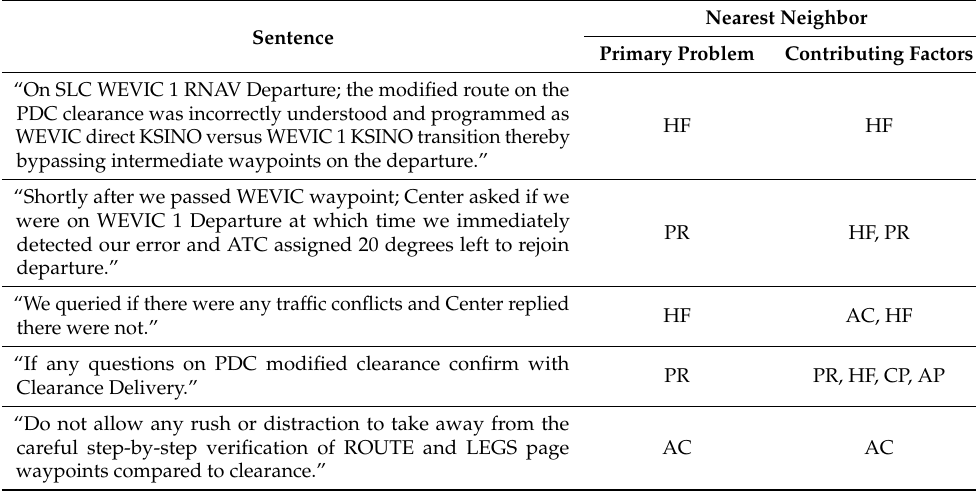
Table A2. Unsupervised sentence-wise primary and contributing factors for the nearest neighbor found in the training corpus for the narrative taken from ACN 819,963, which was coded as “human factors” for primary problem and “human factors” for contributing factors